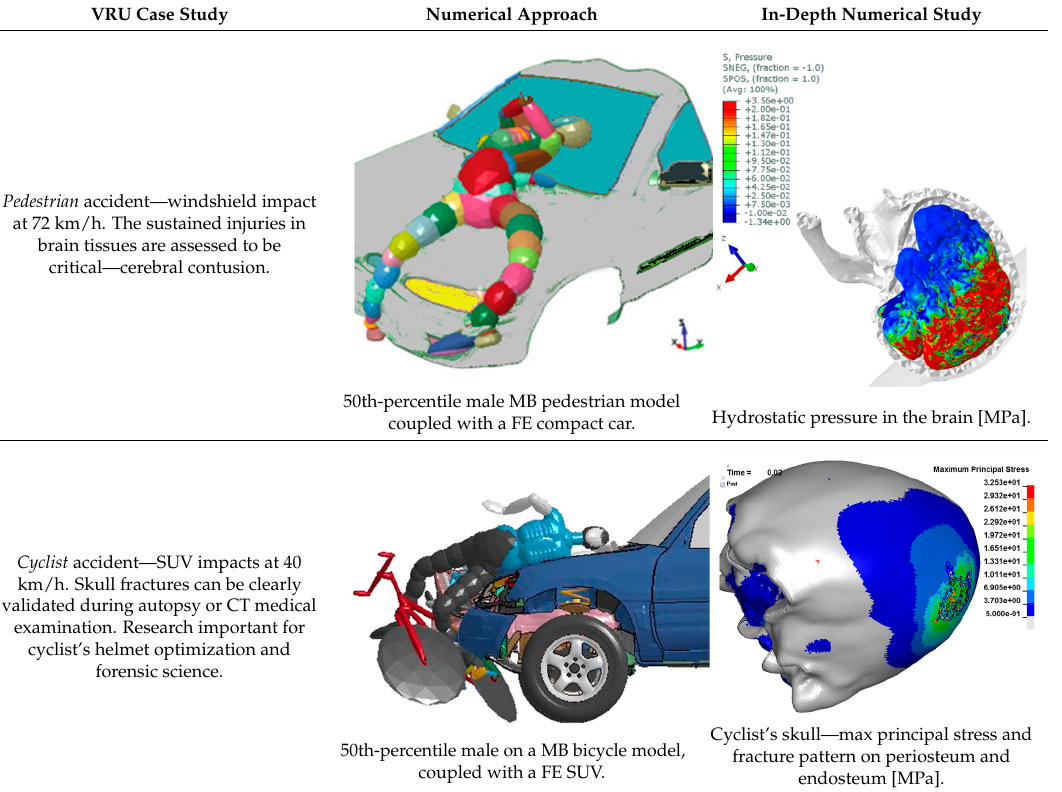
Table 2. The multi-scale vulnerable road user numerical approach to assess safety.